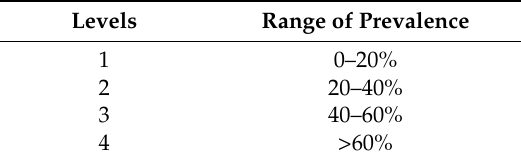
Table 1. Subdivision of the prevalence’s of MRSA, or ESBL, in animals, or in the farming environment, in ranges on a scale of 4 levels. Prevalence’s greater than 60% were assigned maximum